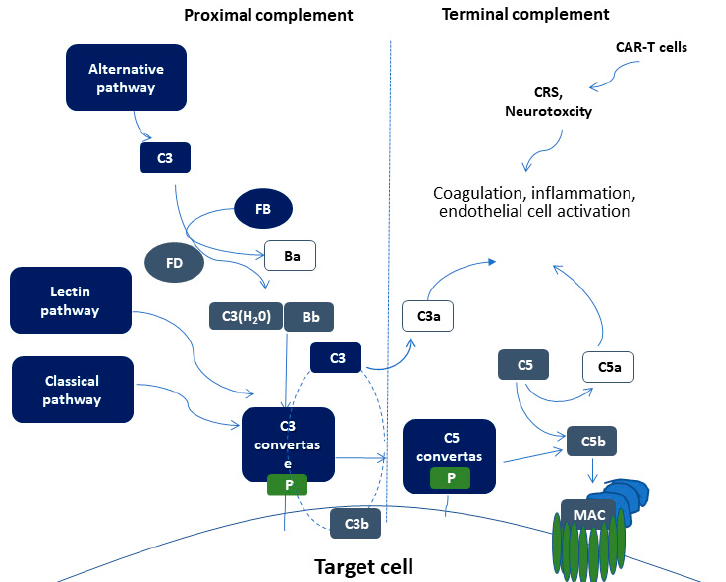
Figure 1. Schematic representation of complement activation. Proximal complement activation initiated by any of the three pathways (classical, alternative, or lectin pathway) leads to C3 activation and C3 convertase formation on C3-opsonized surfaces. C3 activation through the alternative pathway of complement amplifies this response (APC amplification loop, shown in dotted lines), culminating in pronounced C3 fragment deposition on target cells. In the presence of increased surface density of deposited C3b, the terminal (lytic) pathway is triggered, leading to membrane attack complex (MAC) formation on the surface of target cells. C3a and C5a mediate complement interactions with CAR (chimeric antigen receptor)-T cell toxicity syndromes, including CRS (cytokine release syndrome) and